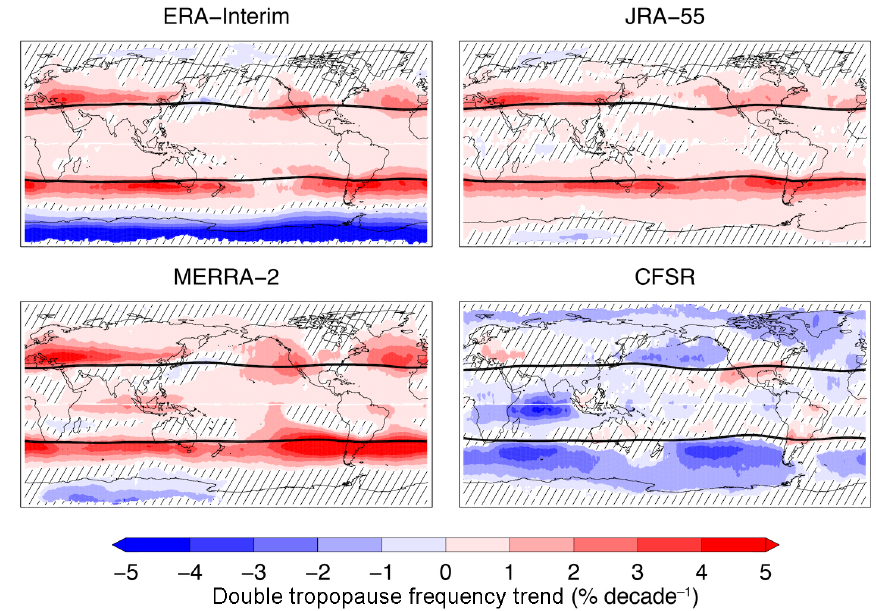
Figure 9. As in Fig. 7, but for reanalyses only in a coordinate relative to the tropopause break.